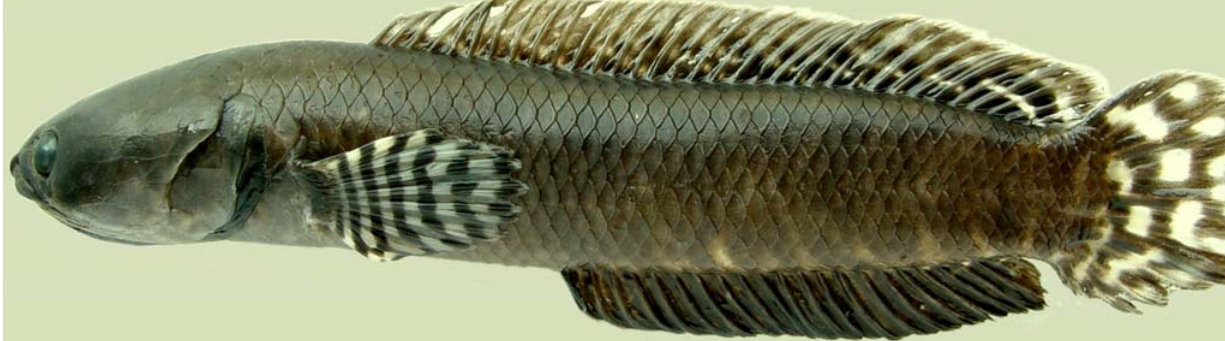
uncat.)Image 5. Side view of Channa bleheri (GUMF uncat)